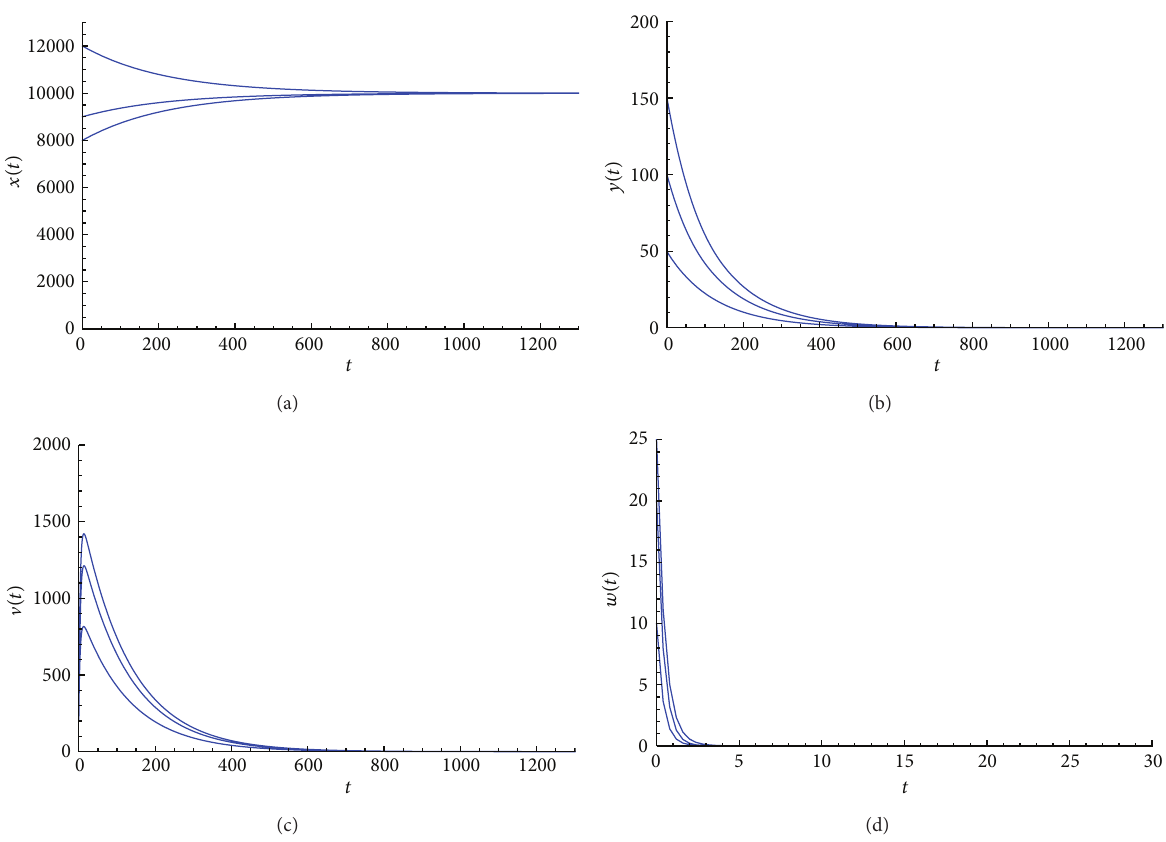
Figure 1: Trajectories of 𝑥(𝑡) , 𝑥(𝑡) , 𝑥(𝑡) , 𝑤(𝑡) for R 1 0 = 0.215743 , R 1 1 = 0.127203 , and 𝐸 0 = (10 4 ,0,0,0) are globally asymptotically stable. 𝑥(𝑡) , 𝑦(𝑡) , V (𝑡) , and 𝑤(𝑡) versus 𝑡 are illustrated by (a), (b), (c), and